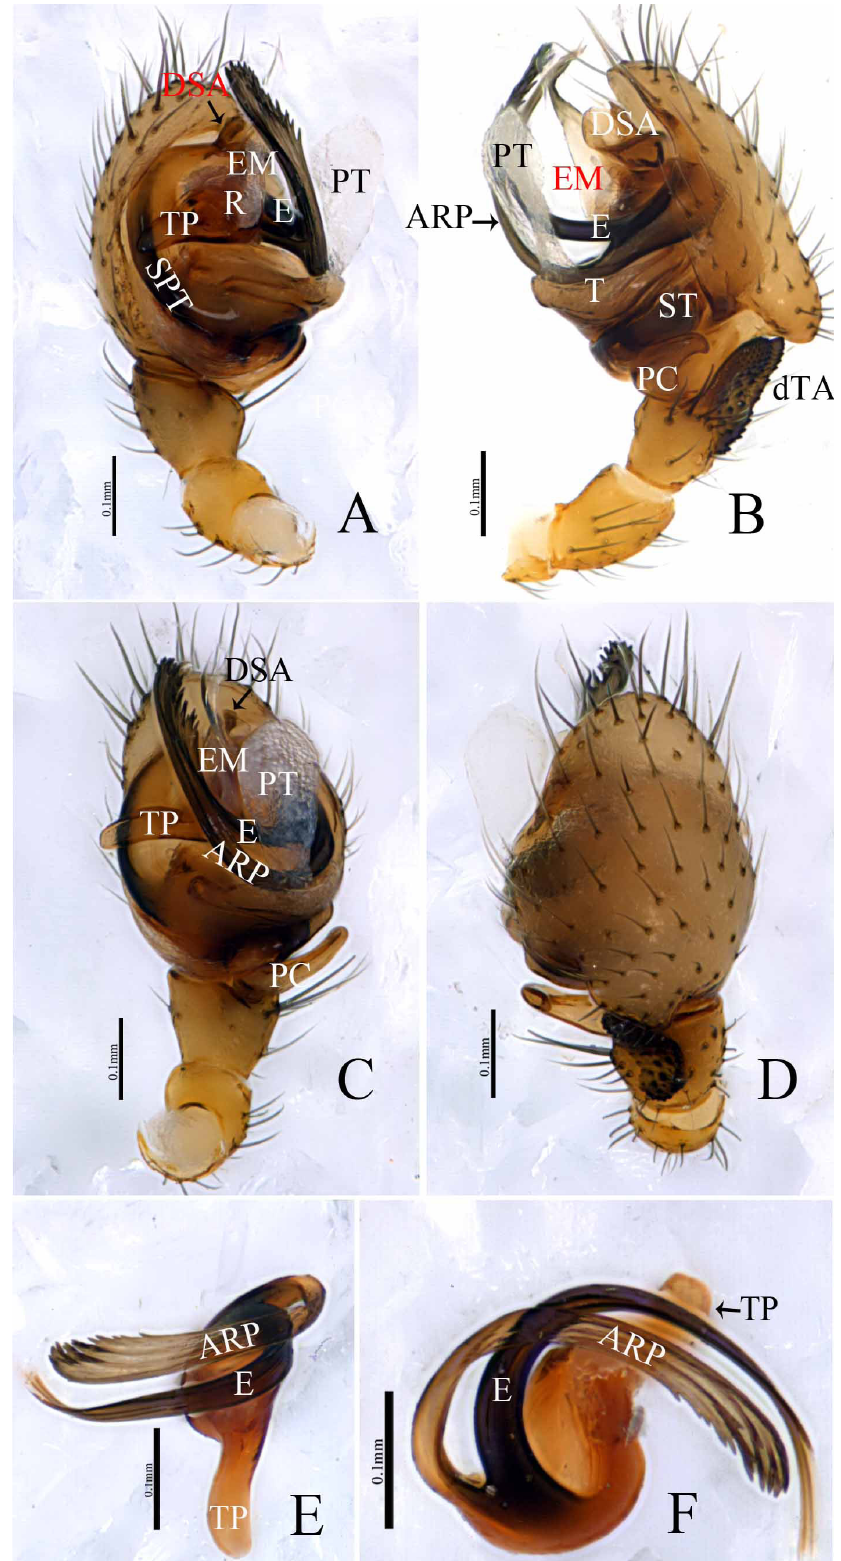
Fig. 6. Yuelushannus barbatus sp. nov., male palp, holotype YLS-17-0301~01. A . prolateral view. B . Retrolateral view. C . Ventral view. D . Dorsal view. E , F . Embolic division. Scale bars: 0.1